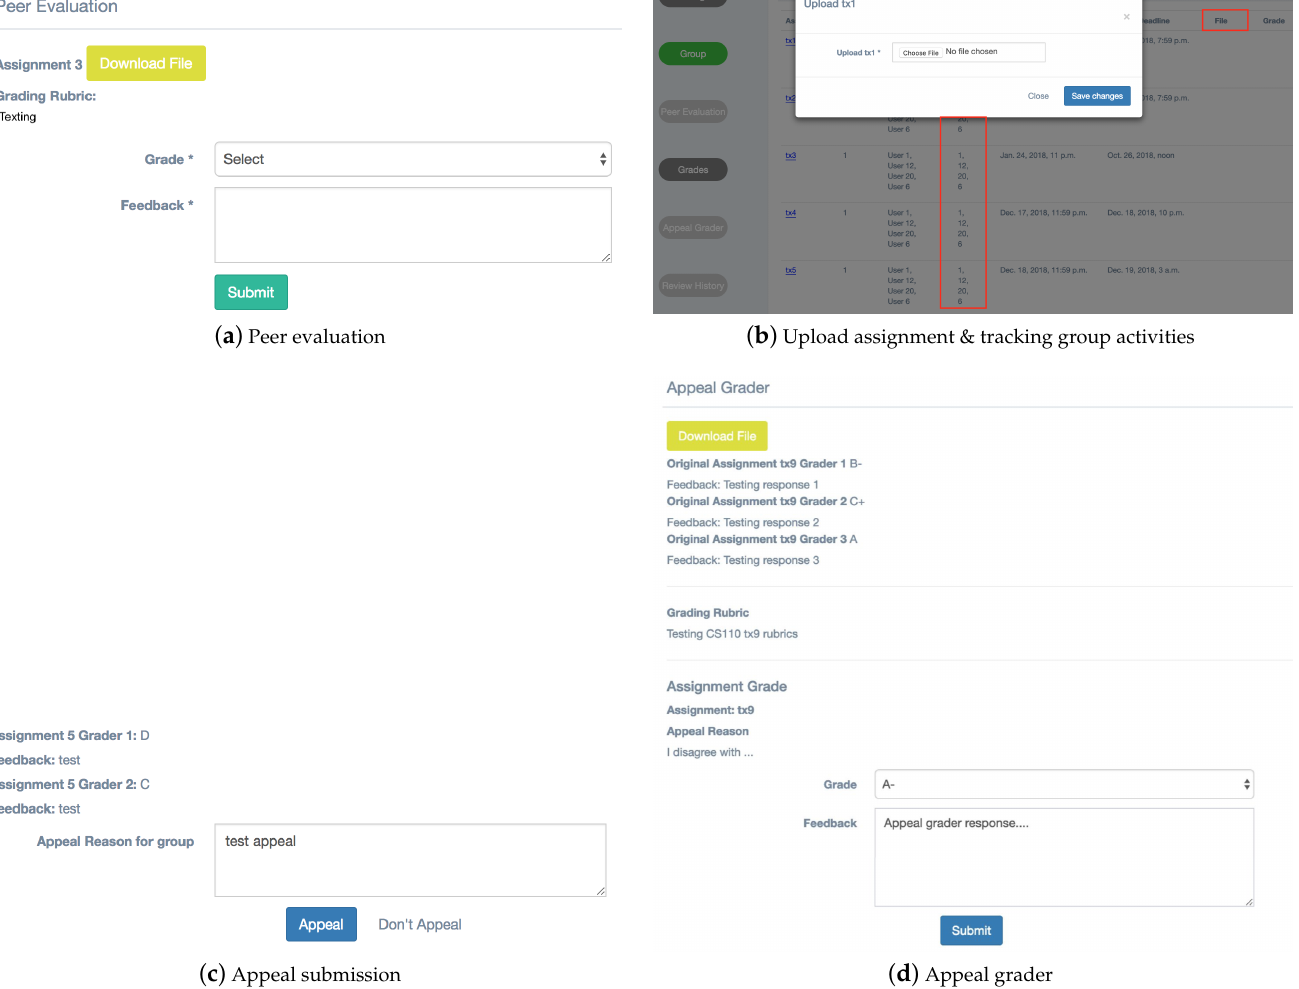
Figure 2. Finalized student user interface. Note that system updates are boxed with red.